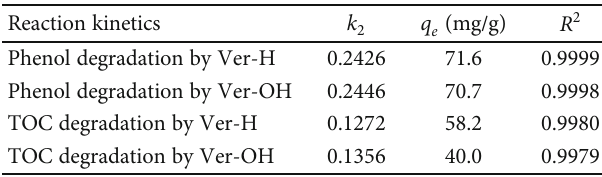
Table 2: Pseudo-second-order kinetic parameters for the degradation of phenol and TOC by